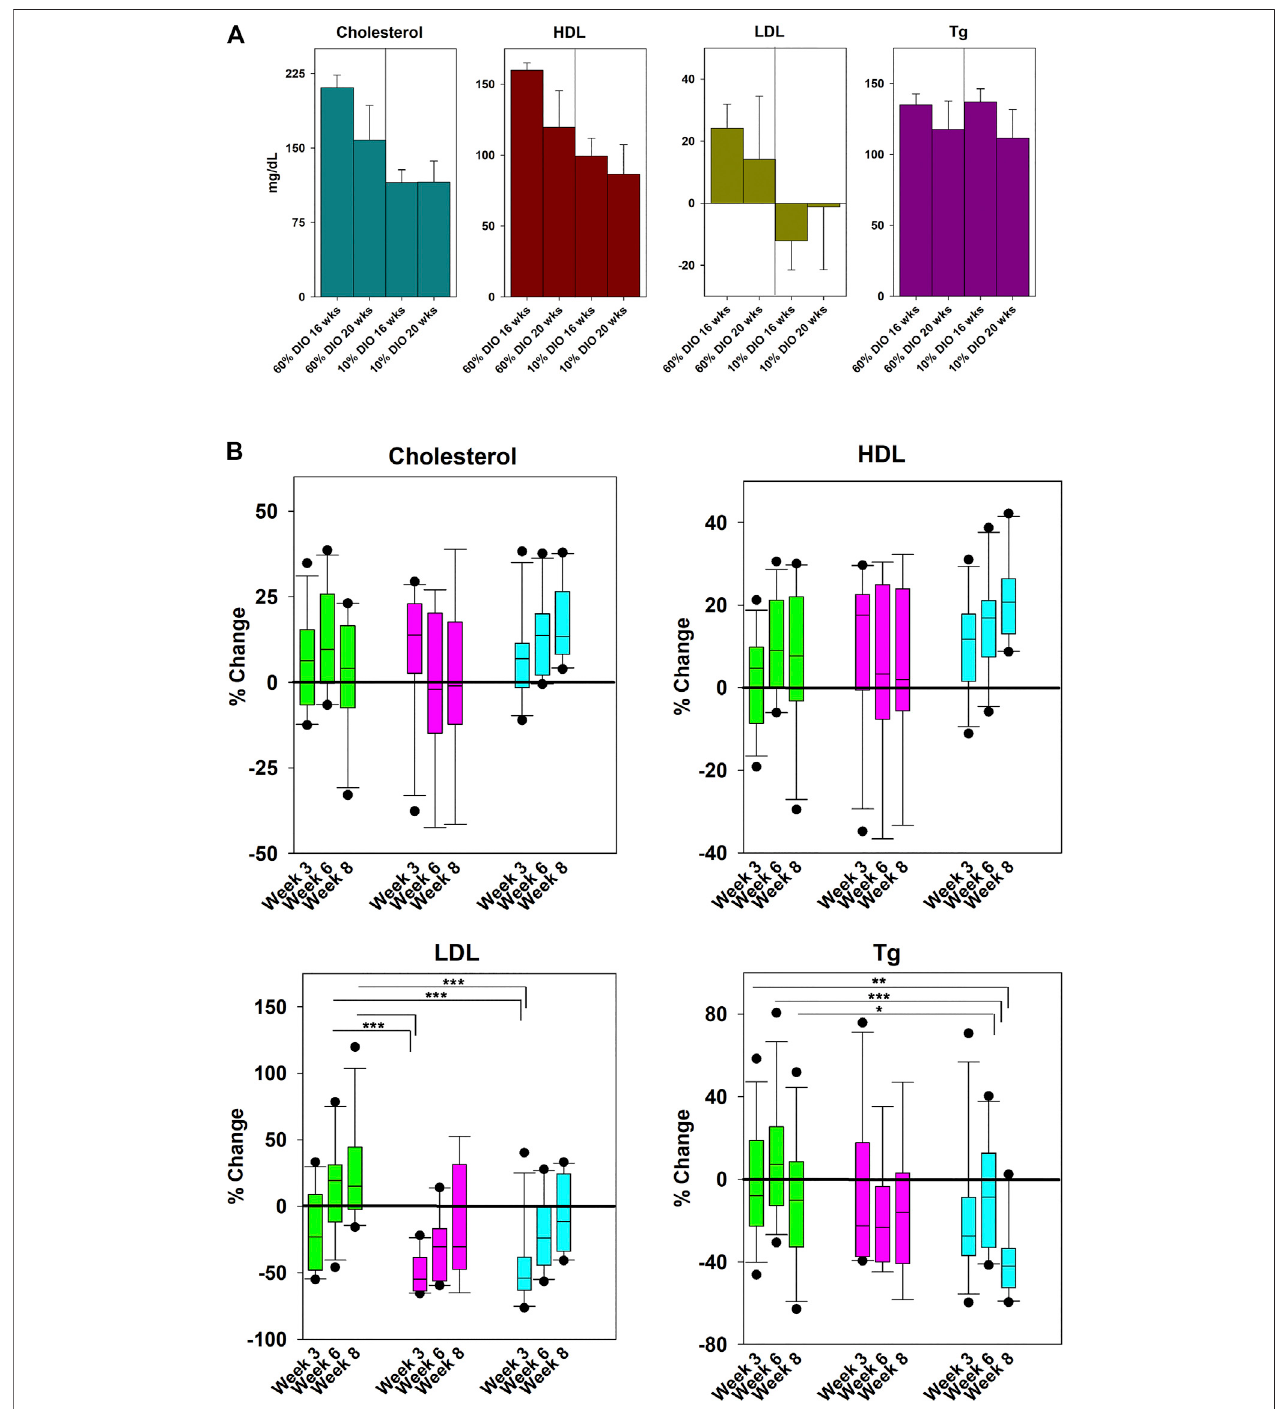
FIGURE 4 | Effects of Diet and Drug Treatment on Cholesterol Levels. (A) To establish the effects of dietary fat on lipoprotein levels in the DIO mouse model, mice were fed a 60% or 10% fat diet (control) for 20 weeks. In mice fed a 60% fat diet, there were signi fi cantly higher total cholesterol levels ( p < 0.001, n (cid:1) 4 mice/diet), HDL levels( p < 0.001,n (cid:1) 4mice/diet),andLDLlevels( p < 0.03,n (cid:1) 4mice/diet)thaninmicefeda10%fatdiet.Therewasnodifferencebetweendietsintriglyceridelevels( p (cid:1) 0.66,n (cid:1) 4mice/diet). (B) Miceonthe60%high-fatdietweretreateddailybyoralgavagewithZetia(ezetimibe,10 mg/kg)orAlphataxin(5 mg/kg).Tocomparethe effectiveness of ezetimibe ( ■ ) and Alphataxin ( ■ ) with vehicle ( ■ ), % change from baseline was calculated as [100-(Treatment-Baseline/Baseline*100)]. Data were not normally distributed. Treatment arms were compared one-way Kruskal-Wallis analysis of variance on ranks and the Mann-Whitney Rank Sum Test to determine signi fi cance of differences between individual treatment groups. Asterisks designate a statistically signi fi cant difference at the designated weeks, * p < 0.05, ** p < 0.01, *** p <